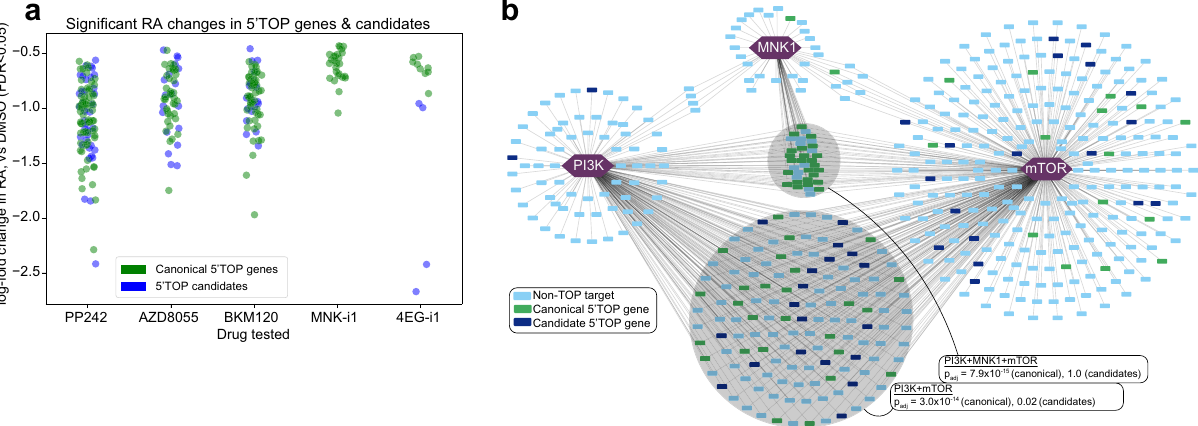
Figure 7. Distribution of TOP Motif-Containing Genes and Candidates in a Modeled Translational Control Network in TS-543 cells. ( a ) TOP genes and candidates significantly perturbed in RA by drug treatments. Strip plots along the X axis, labeled for each drug treatment in our riboPLATE-seq study, contain log-fold changes in RA (Y axis) for the genes exhibiting significant RA perturbations (FDR < 0.05) under each treatment relative to DMSO controls, excluding non-TOP-containing genes. TOP candidates behave similarly to canonical TOP genes, exhibiting decreased RA under treatment with mTOR axis inhibitors (PP242, AZD8055, BKM120) while MNK-i1 and 4EGi-1 elicit fewer significant alterations in these sets. ( b ) Network representation of targets of mTOR, PI3K, and MNK1, interpreted as the genes exhibiting significant decreases in RA under treatment with PP242, BKM120, and MNK-i1, respectively (FDR < 0.05). Targets are color-coded for identification as canonical 5’TOP motif-containing genes (green), TOP gene candidates with known mouse homologues (navy blue) and other genes (light blue). Shaded circles denote subsets of the network with significant enrichment of canonical and/or candidate TOP genes, with the Fisher’s exact test p -value for either set displayed. P -values are corrected for multiple testing over all gene sets and network intersections tested via Benjamini-Hochberg (false discovery rate/FDR) adjustment. The intersection of all three kinases is enriched for canonical TOP genes, but not candidates (Fisher’s exact test p adj = 7.9 × 10 –15 and p adj = 1.0, respectively), while the intersection of PI3K and mTOR is significantly enriched for canonical TOP genes and less-significantly enriched for candidates ( p adj = 3.0 × 10 –14 and p adj =